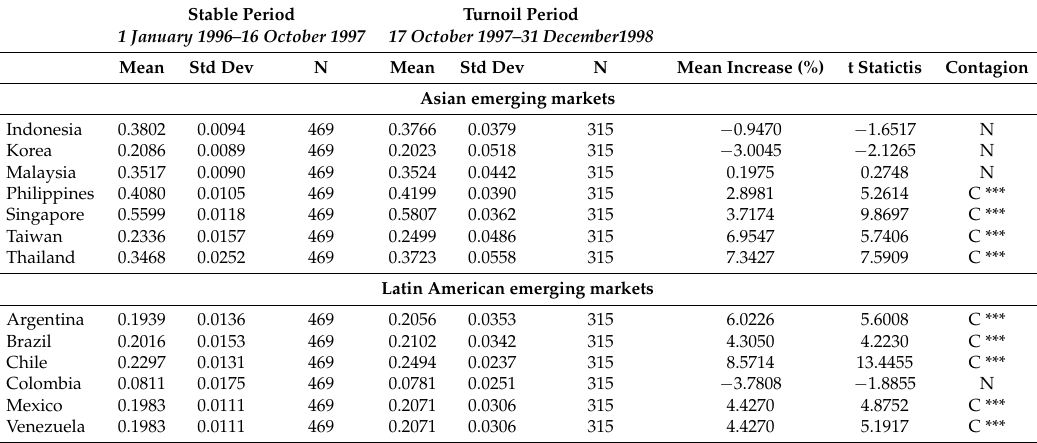
Table 10. Results of contagion test in emerging stock markets: Asian “flu” crisis in 1997 (Contagion source: Hong